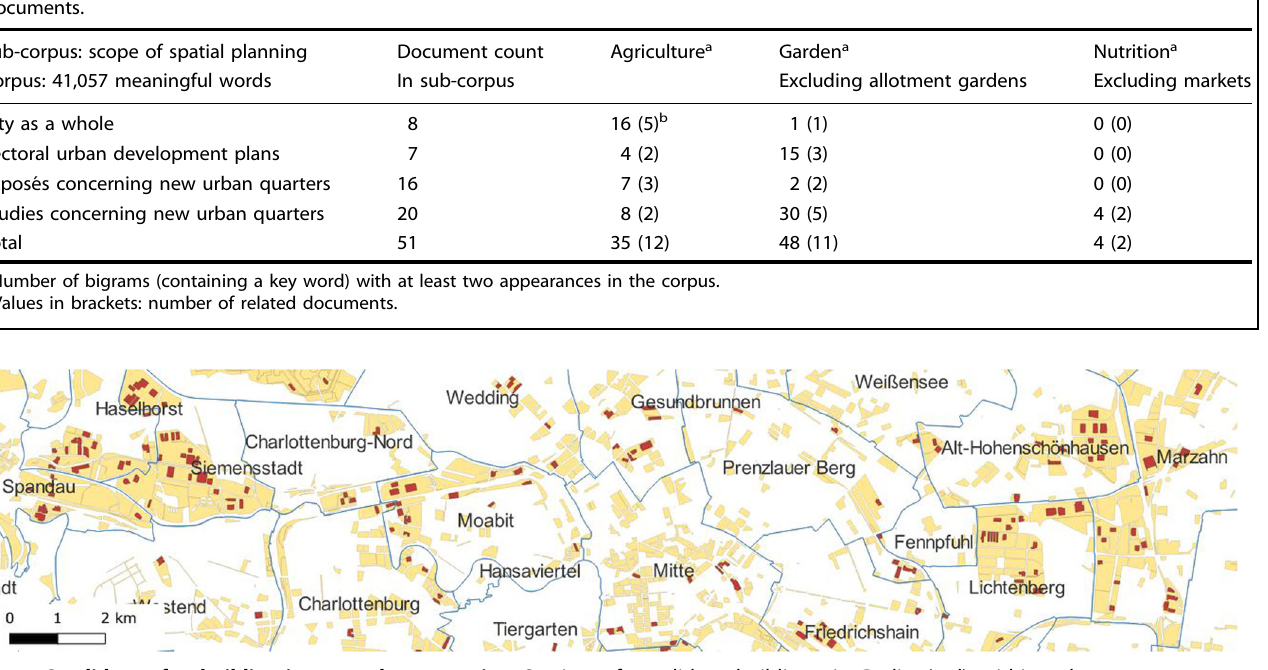
Fig. 2 Candidates for building-integrated aquaponics. Section of candidate buildings in Berlin (red) within urban structure types appropriate for aquaponic sites (yellow); city district names (black); CC-BY 4.0 Gösta F.M. Baganz/dl-de/by-2-0 Geoportal Berlin [ALKIS Berlin Ortsteil, Bauwerke]/Umweltatlas Berlin [Stadtstruktur